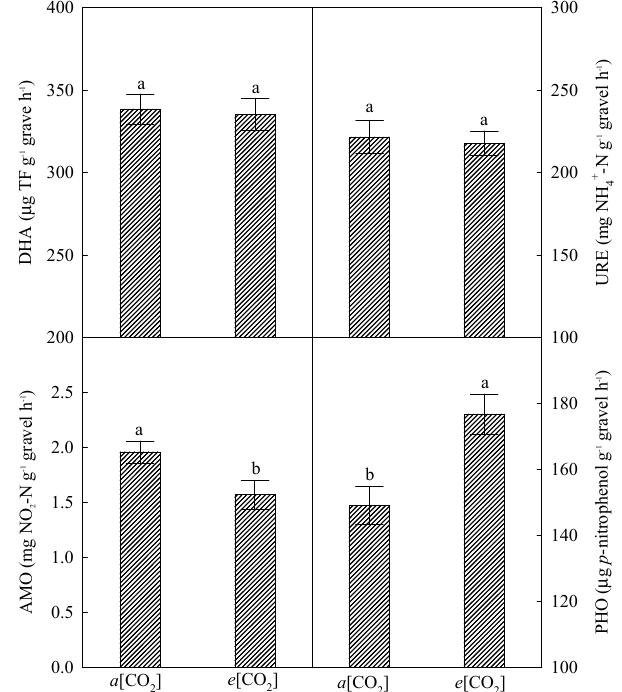
Figure 5. Activities of dehydrogenase, urease, ammonia monooxygenase, and phosphatase of microorganisms on the gravel under ambient ( a [CO 2 ], 400 ppm) and elevated ( e [CO 2 ], 800 ppm) atmospheric CO 2 concentrations. Different small letters mean significant difference at p < 0.05 level. Data are expressed as means ± SEM (n = 3).